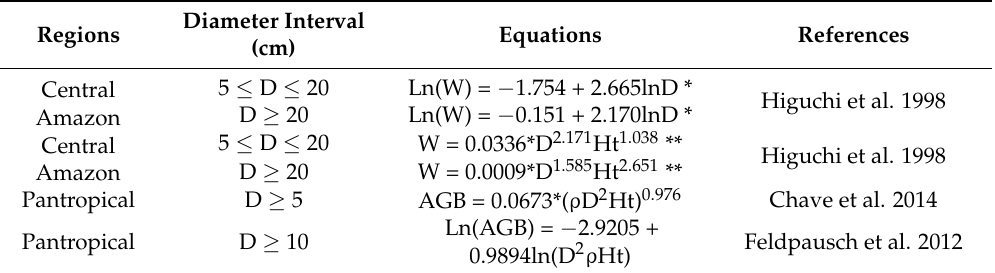
Table A1. The equations for estimating the aboveground biomass (in kg) with diameter (D in cm), total height (Ht in m), and wood density ( ρ in g/cm 3 ).